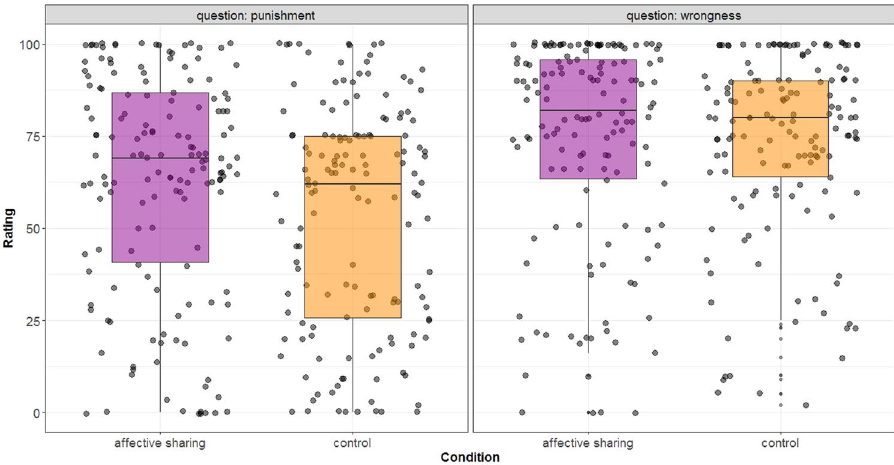
Figure 4. Instructional affective sharing increases punishment for accidents. Boxplots with jittered data-points show participants’ wrongness and punishment judgments in two conditions: when they were instructed to share the victim’s pain (affective sharing group) and when no such instruction was provided (control group). Instructional affective sharing increased punishment ratings, but left wrongness judgments